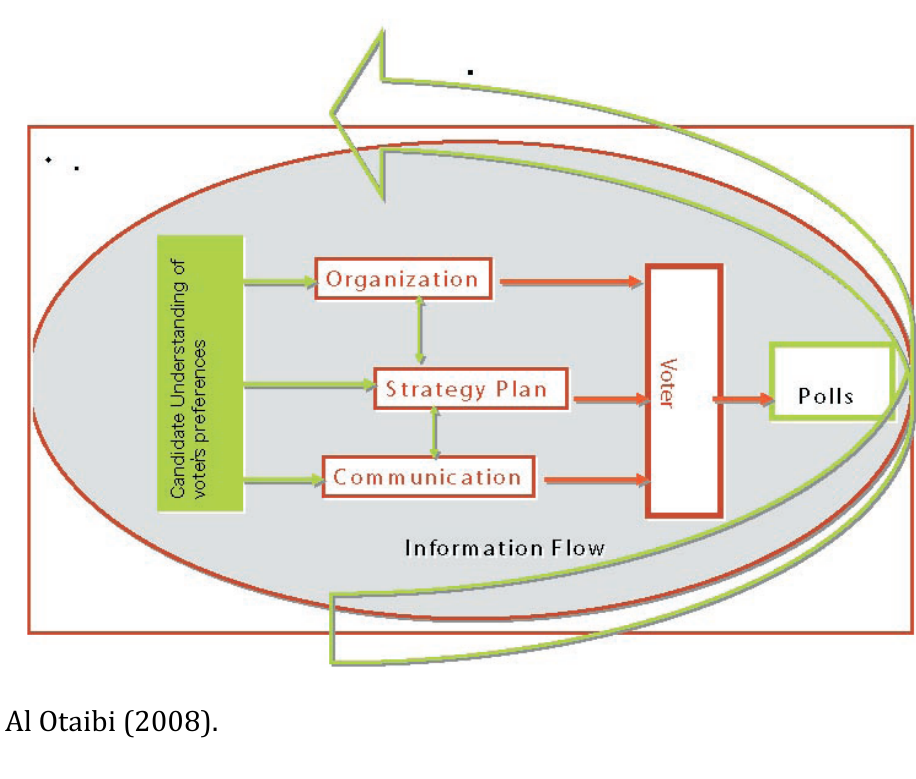
Source : Al Otaibi (2008).